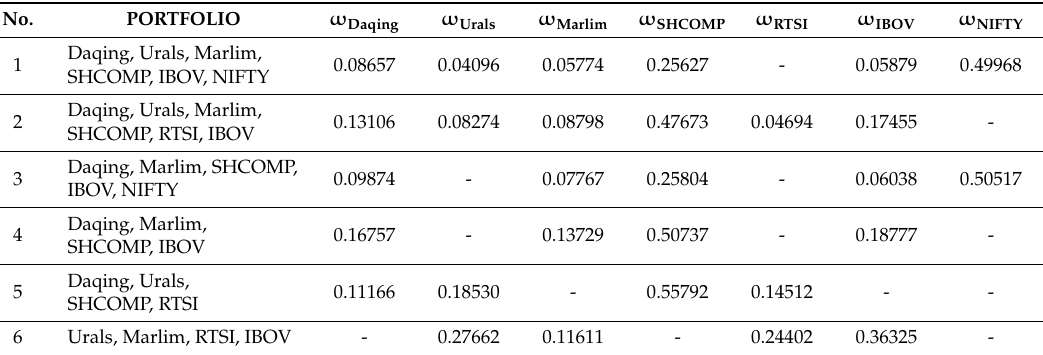
Table 3. Asset weights obtained for suggested portfolios 1 to 6 considering the 1st and 2nd moments of the adjusted MNIG distribution. From these weights, the expected returns and the standard deviation of each portfolio were calculated. Elaborated by authors with data from Bloomberg.